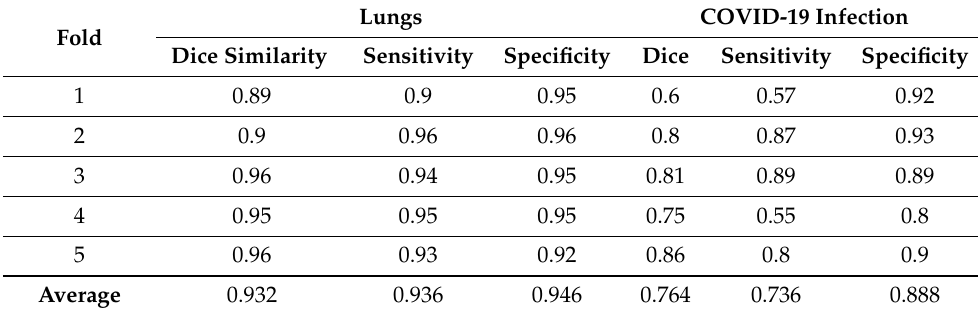
Table 2. Results obtained for each cross-validation fold.